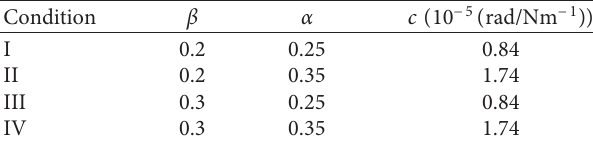
Table 1: The crack